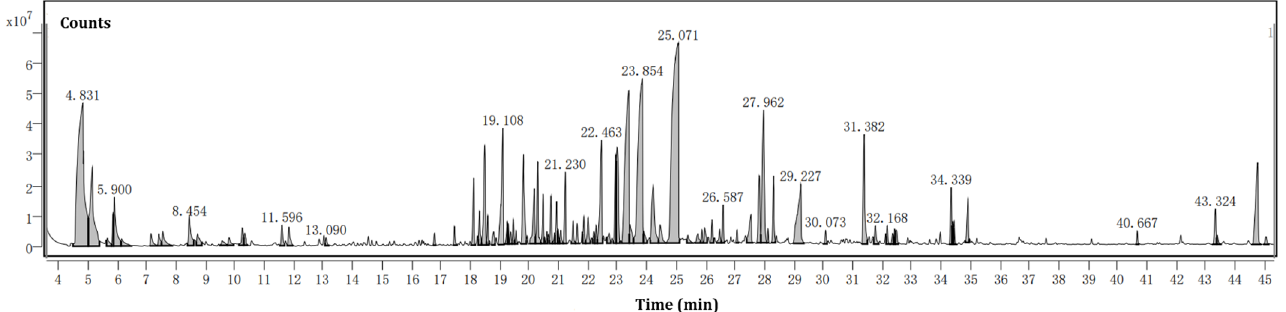
Figure 2. Chromatogram of the VOCs distilled from the biomass of F. hispida.